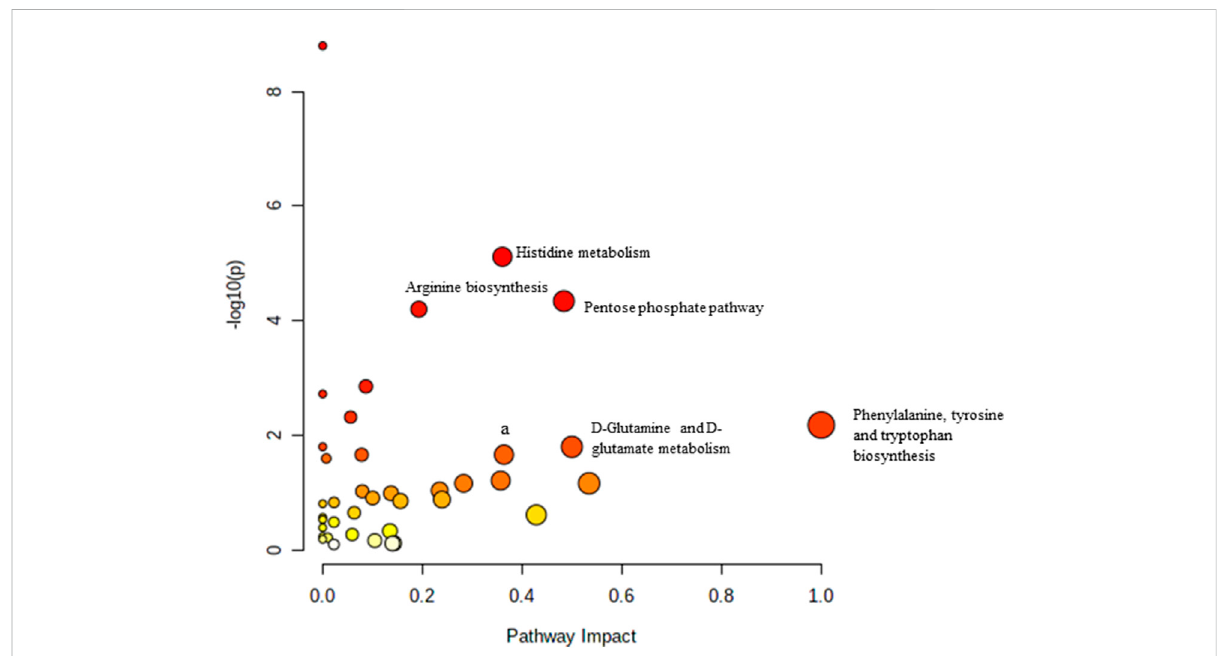
FIGURE 4 Biochemical pathway analysis of metabolites pro fi led for AC vs. OC. a: Fructose and mannose metabolism.